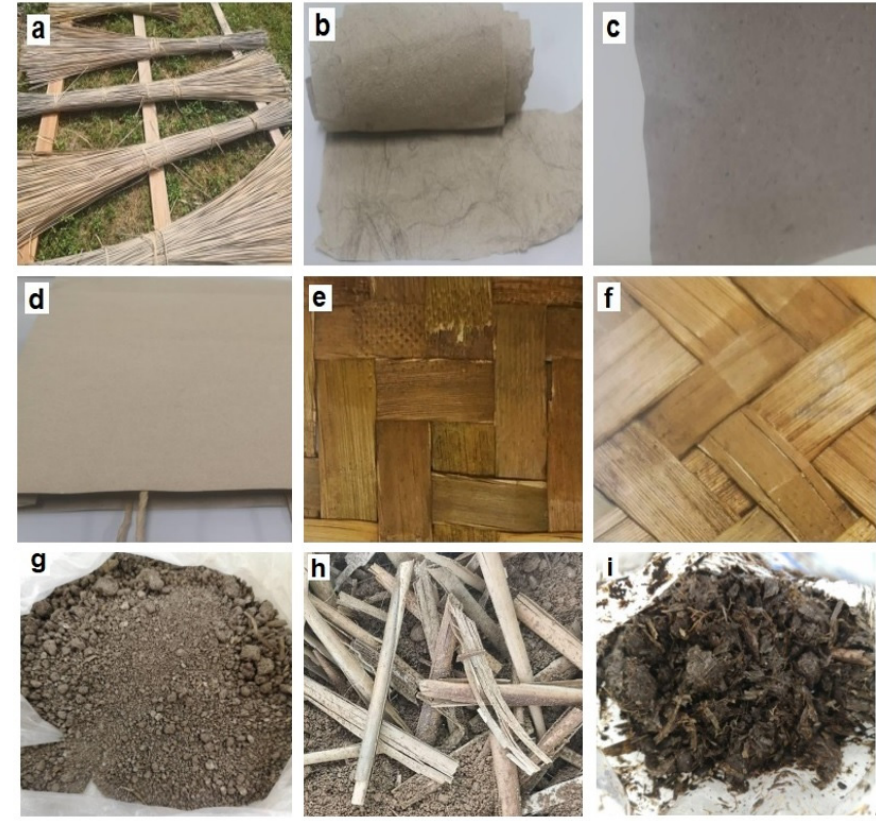
Figure 1. Samples used in this research: ( a ) Krajood strips (KS), ( b ) paper made from Krajood (PK), ( c ) shirt backing paper (SP), ( d ) a bag made of paper (BP), ( e ) residue of plain weave pattern (RPP), ( f ) residue of cross weave pattern (RCP), ( g ) loam soil, ( h ) Krajood strip residue in combination with loam soil (KSRL) at day 0, ( i ) Krajood strip residue in combination with loam soil (KSRL) at day 60.